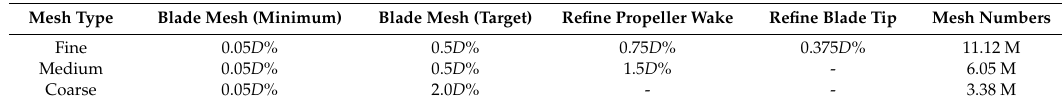
Figure 3. Volumetric control refinement for the tip vortex.